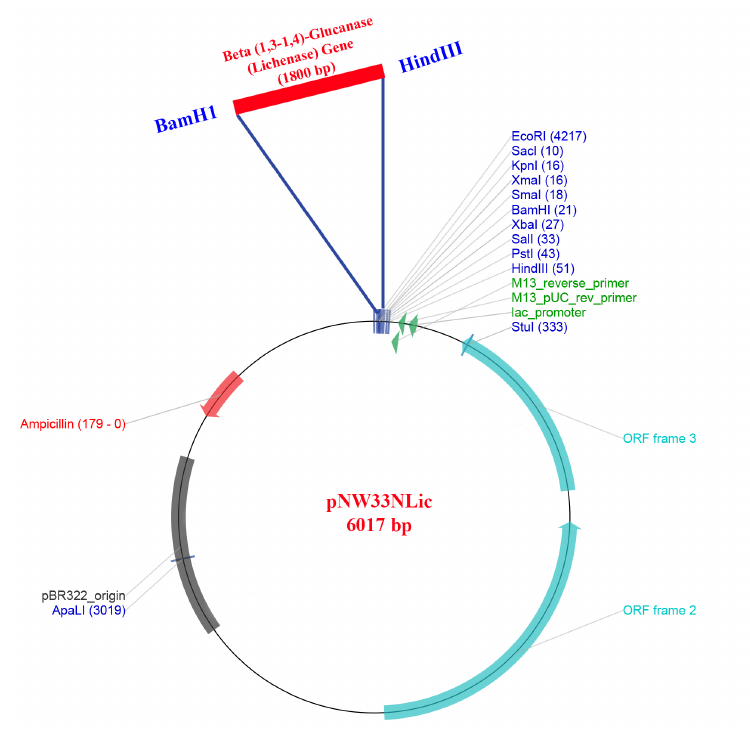
Figure 1. Structure of pNW33NLic plasmid (pNW33N (4217 bp) plus lichenase gene (1800